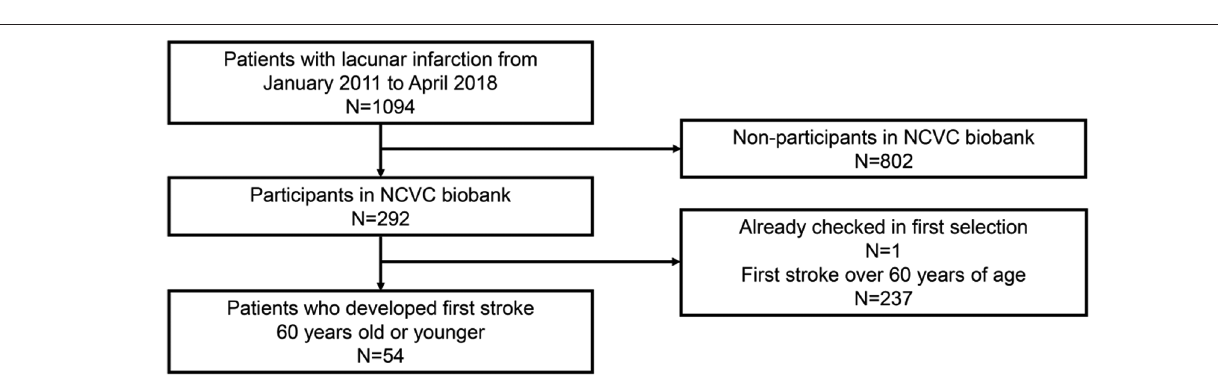
FIGURE 2 | Patient selection flow diagram for the phase 2 cohort. NCVC, National cerebral and cardiovascular